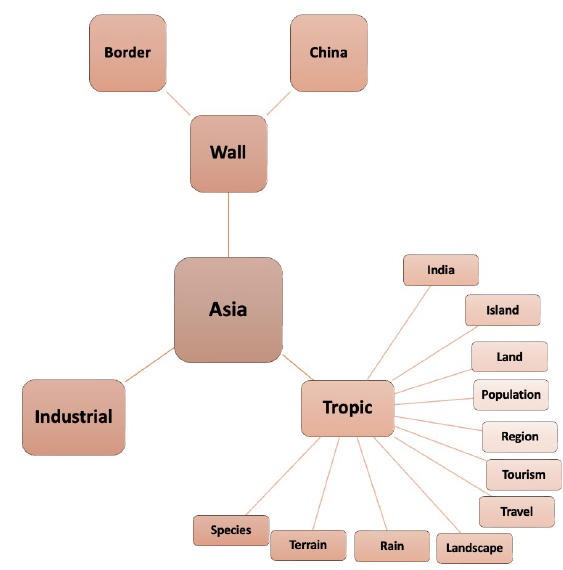
Figure 7. Associations Diagram for the word